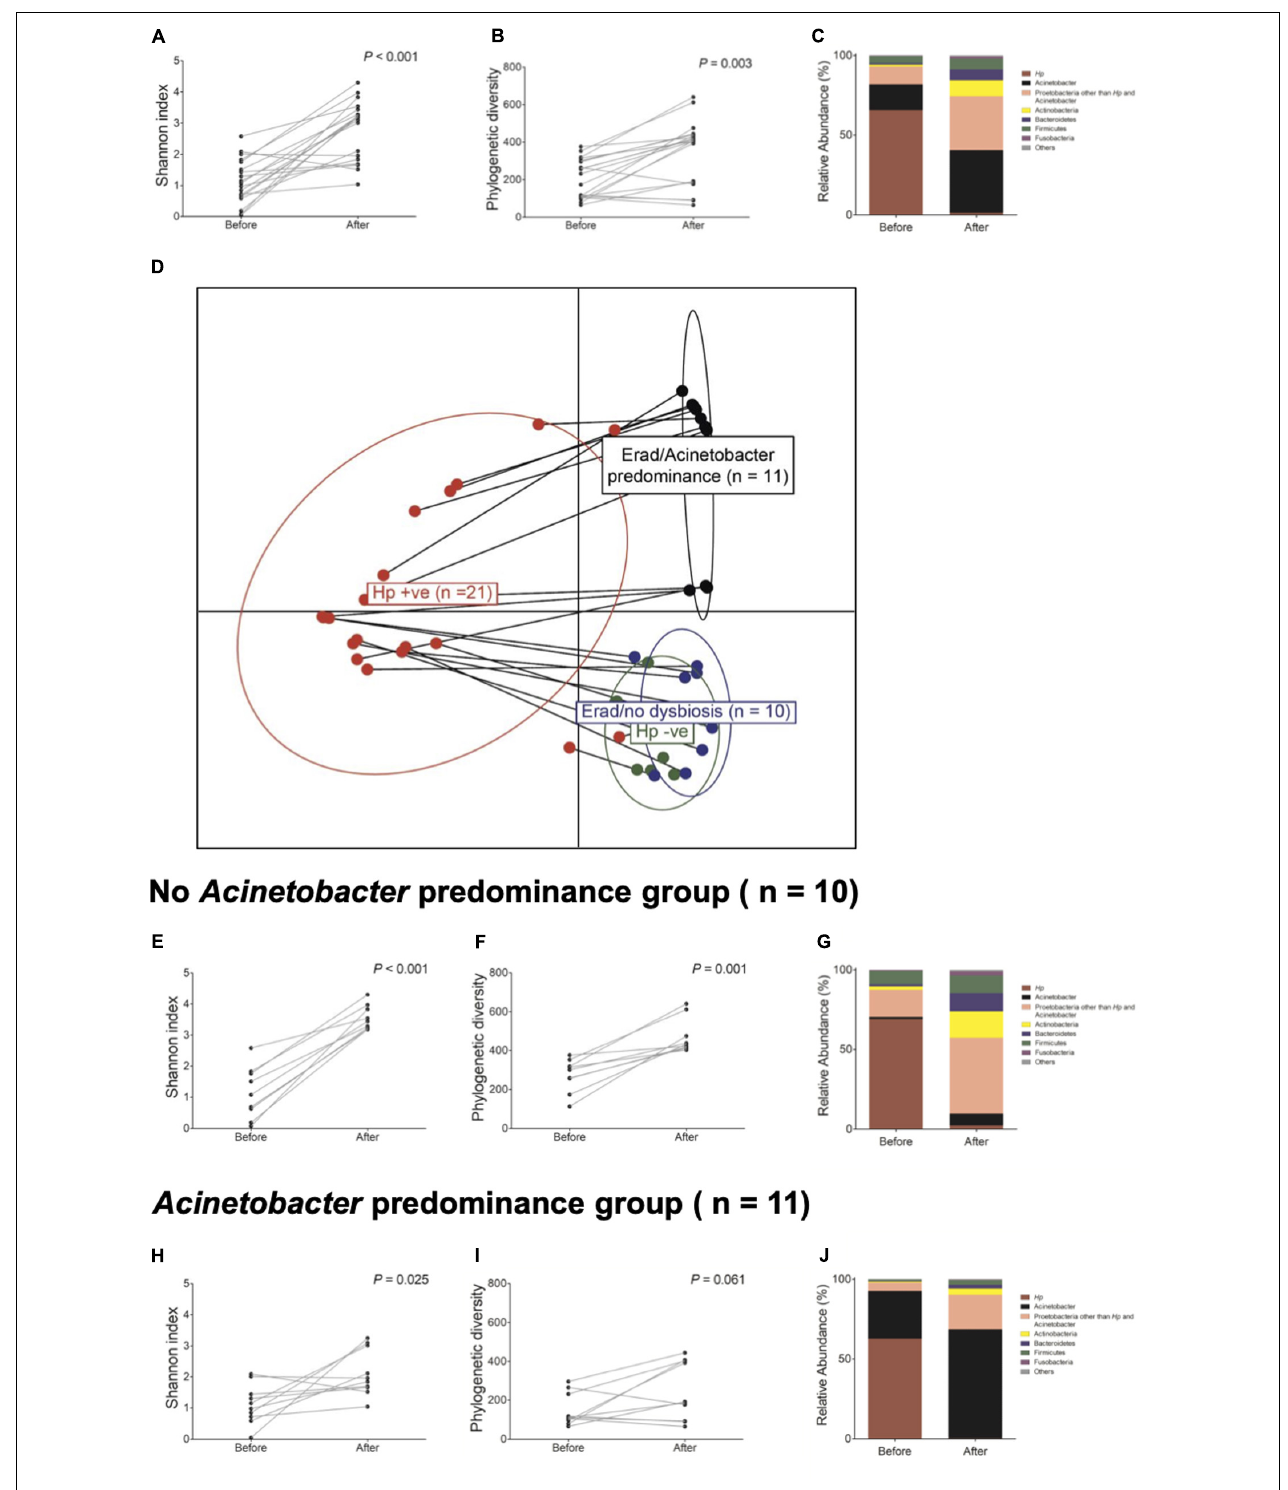
FIGURE 4 | Changes in gastric microbiota after H. pylori eradication. H. pylori eradication led to an (A,B) increase in microbial diversity and a (C) restoration of gastric microbiota. After H. pylori eradication, two district clusters can be identified ( D eradicated without Acinetobacter predominance vs. eradicated with Acinetobacter predominance). (E–G) In the eradicated without Acinetobacter predominance group ( n = 10), eradication of H. pylori led to a restoration of diverse gastric microbiota composition. (H–J) However, in the eradicated with Acinetobacter predominance group ( n = 11), severe dysbiosis with an increase in Acinetobacter species abundance and a decrease in microbial diversity was